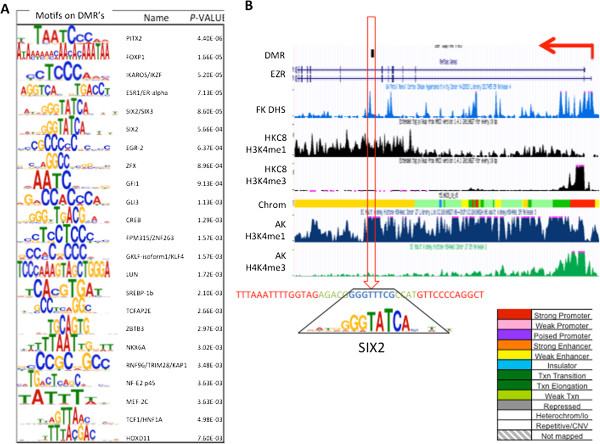
Chronic kidney disease differentially methylated regions are enriched for kidney-specific transcription factor binding sites. (A) The DMR and DHS sites contain consensus sequences. The transcription factor binding site motifs and their statistical enrichment from the de novo searched consensus sequences in DMR and DHS sites. (B) A specific example of an intronic DMR (within the EZR gene). The genomic location of the DMR is at the top, followed by the RefSeq representation of EZR; fetal kidney (FK)-specific DHS tracks (in blue); HKC8 cell-specific H3K4me1 and H3K4me3 tracks; HKC8 cell specific ChromHMM annotation of the locus (yellow, enhancer; red, promoter; green, transcription-associated region; the full color coding key is shown bottom right) - the sequences contain consensus-binding sites for the key kidney transcription factor SIX2/3, with the SIX2/3 binding motif illustrated as a sequence logo plot below; and adult kidney (AK)-specific H3K4me1 (blue) and H3K4me3 (green) tracks [19].